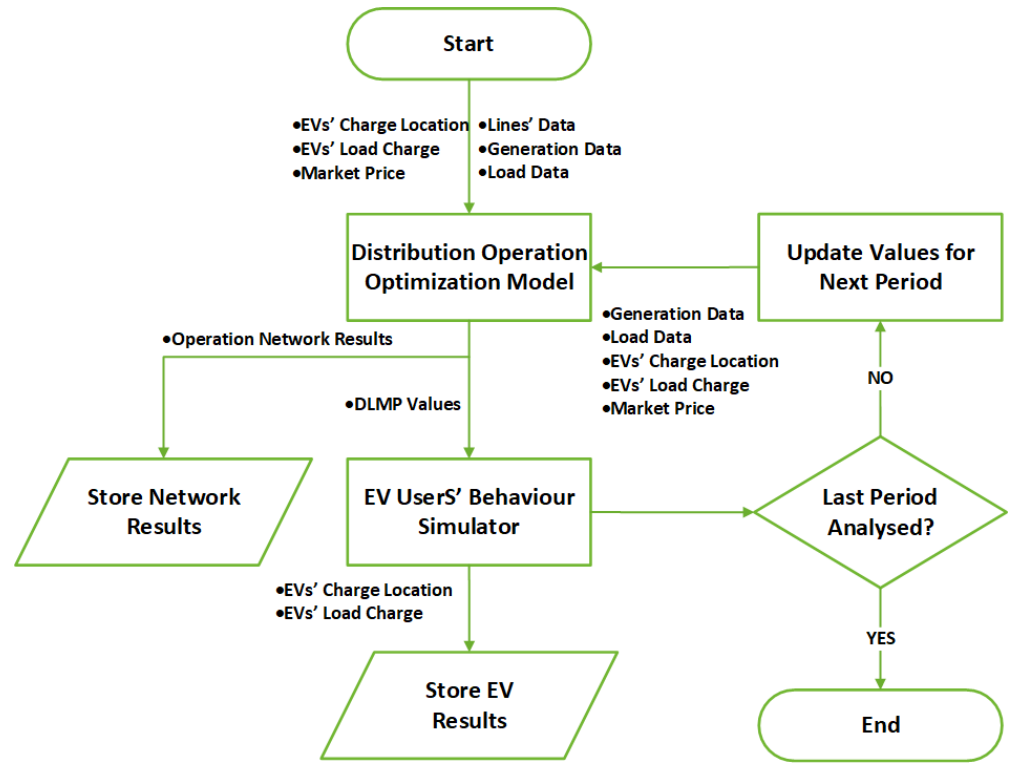
Figure 1. The proposed methodology’s